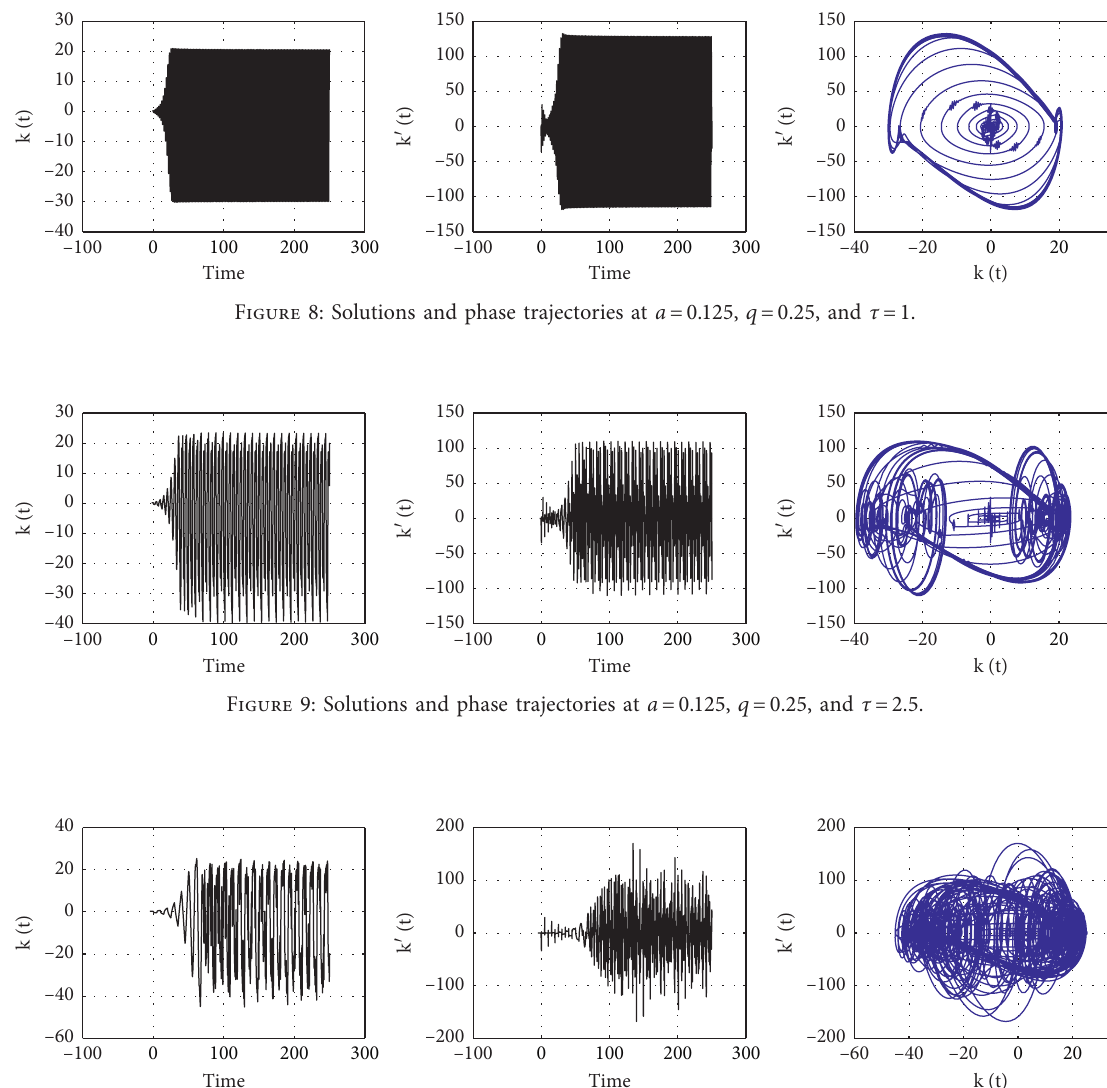
Figure 10: Solutions and phase trajectories at a � 0.125, q � 0.25, and τ �